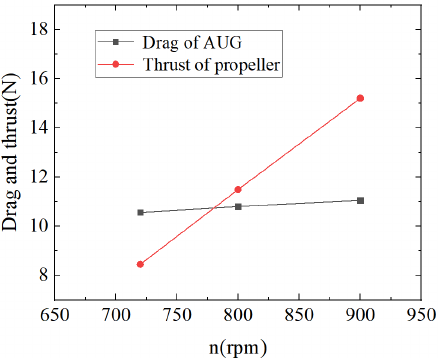
Figure 30. Self-propulsion simulation results of the AUG with the CRP.